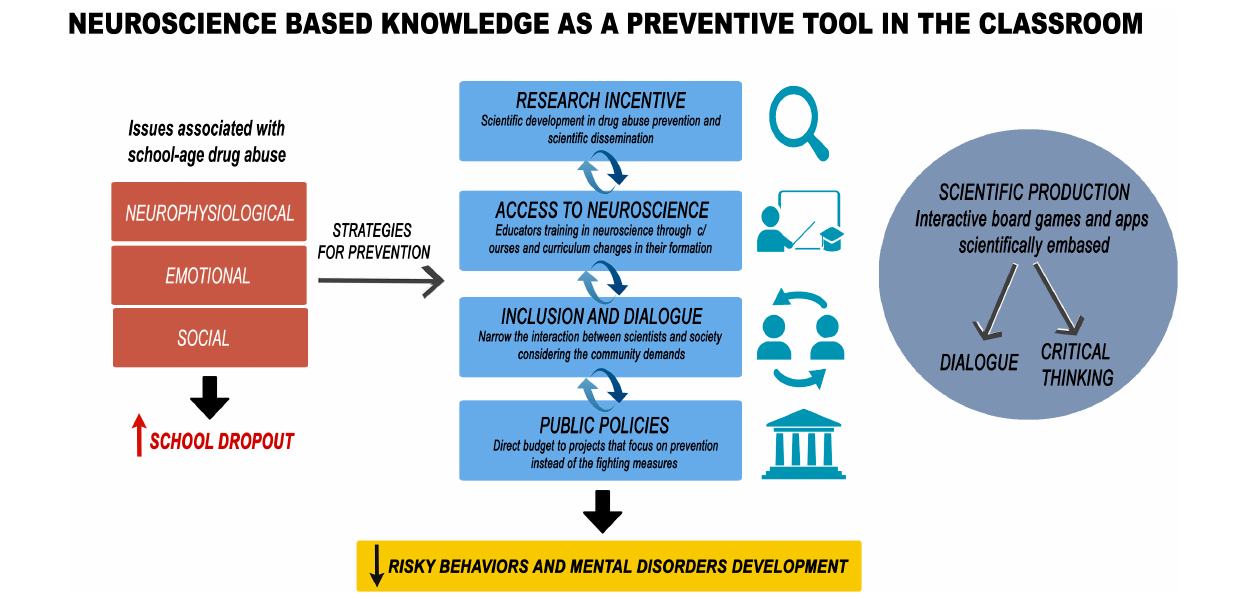
FIGURE 1 | This figure illustrates our view of what a successful educational drug abuse prevention program should include. On the left side, we list the main issues associated with school-age drug abuse, which include neurophysiological, emotional, and social factors that are known to increase rates of school dropout. On the right side of the figure are efforts of scientific production, including interactive games and courses, which generate dialogue and critical thinking and, in turn, promote research incentives, access to neuroscience, inclusion and dialogue, and public policies (middle panel), all of which can help reduce risky behaviors and mental